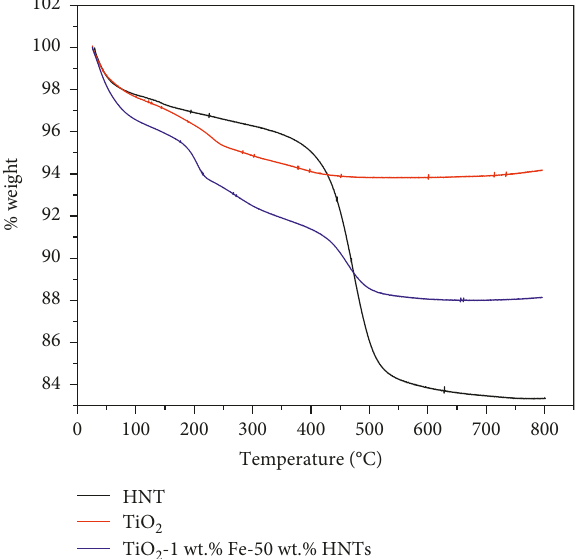
2 and TiO 2 -Fe-HNTs (“ ∗ ” Figure 5: TGA curves for HNTs, TiO